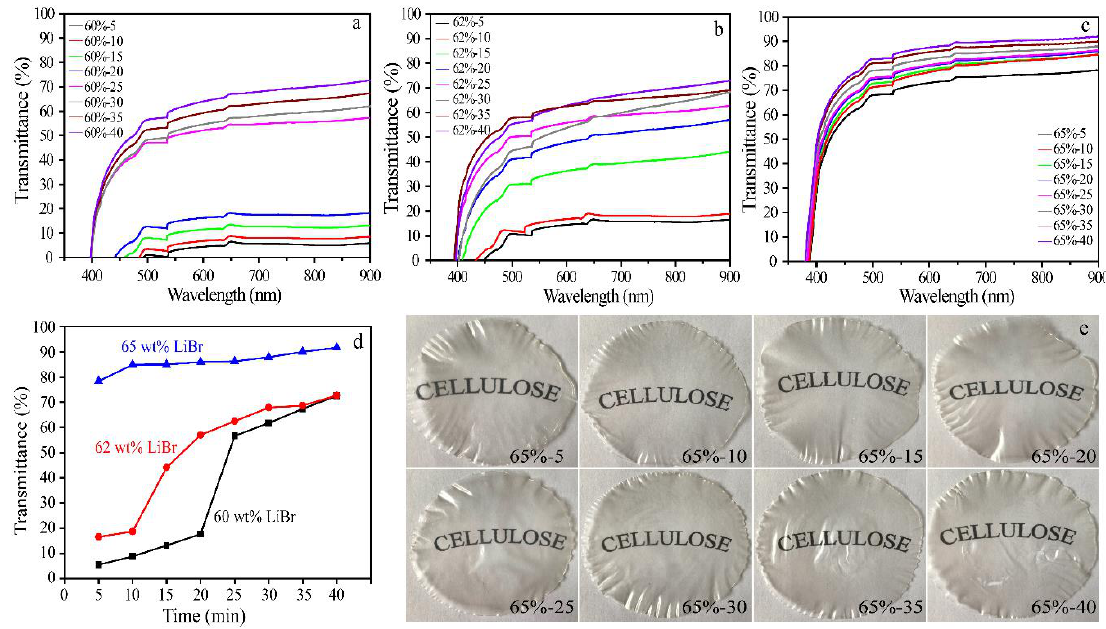
Figure 5. Light transmittance graphs of cellulose films prepared under various conditions ( a – c ), and plotting the light transmittance of cellulose films ( d ), and the photographs of cellulose films prepared in 65 wt % LiBr molten salt hydrate with varied dissolution time ( e ).